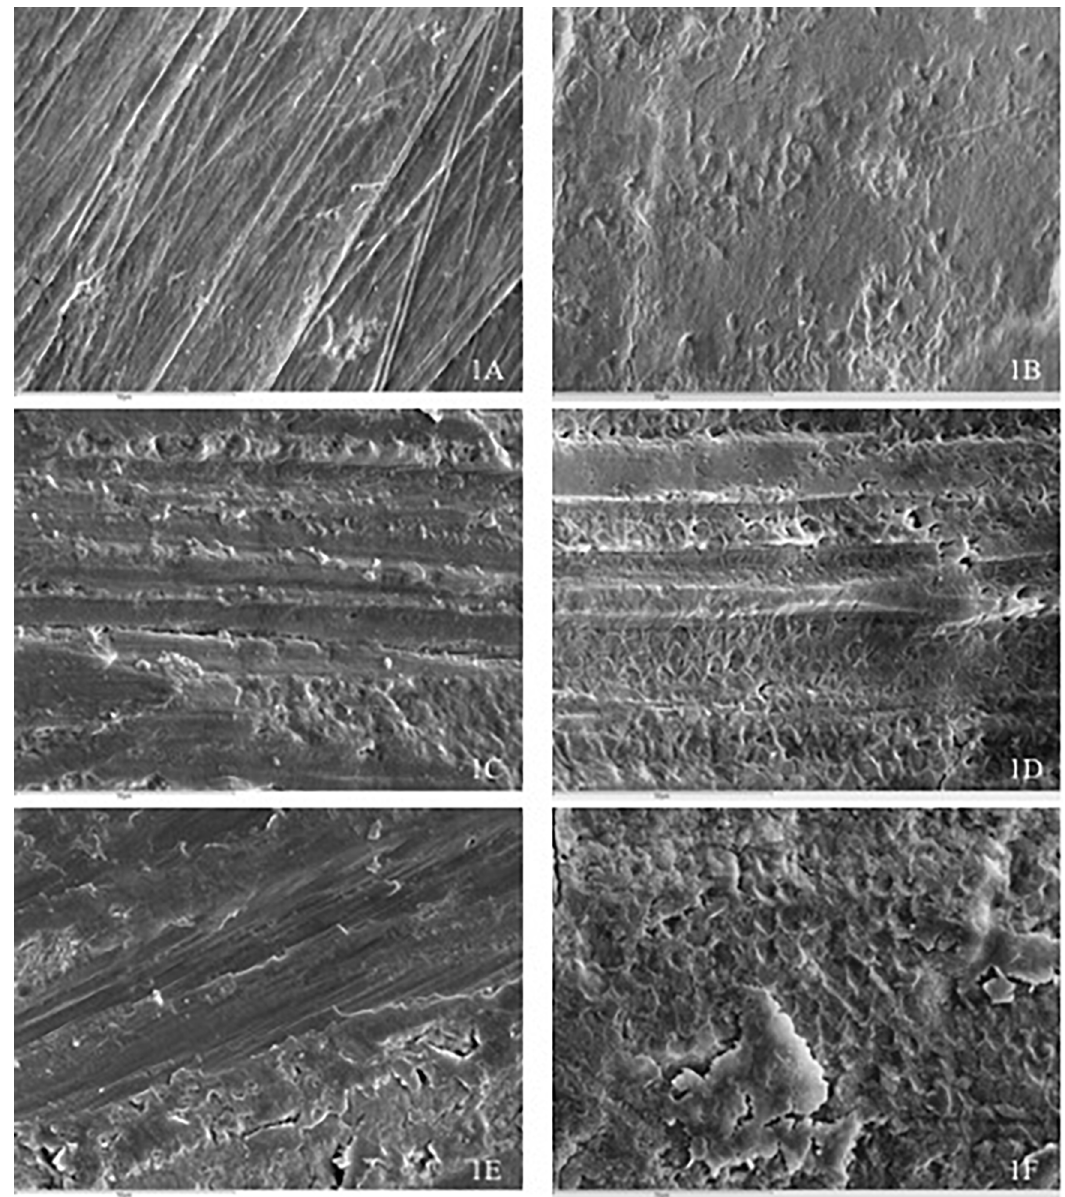
enamel reduction. On the dental surfaces of IR + DC group samples, areas with preferential destruction of the centre of the prism nuclei and indiscriminate destruction could be observed in some areas (Fig 1D). RI + Profluorid +CD images did not show demineralization, and the images were similar to the IR group (Fig 1E). But in IR + Clinpro + DC sample images, a typi- cal honeycomb pattern of demineralization could be seen, with preferential dissolution of the prism nuclei; in spite of sample cleaning with a dental prophylaxis brush, remains of the var- nish were observed in most of the images (Fig